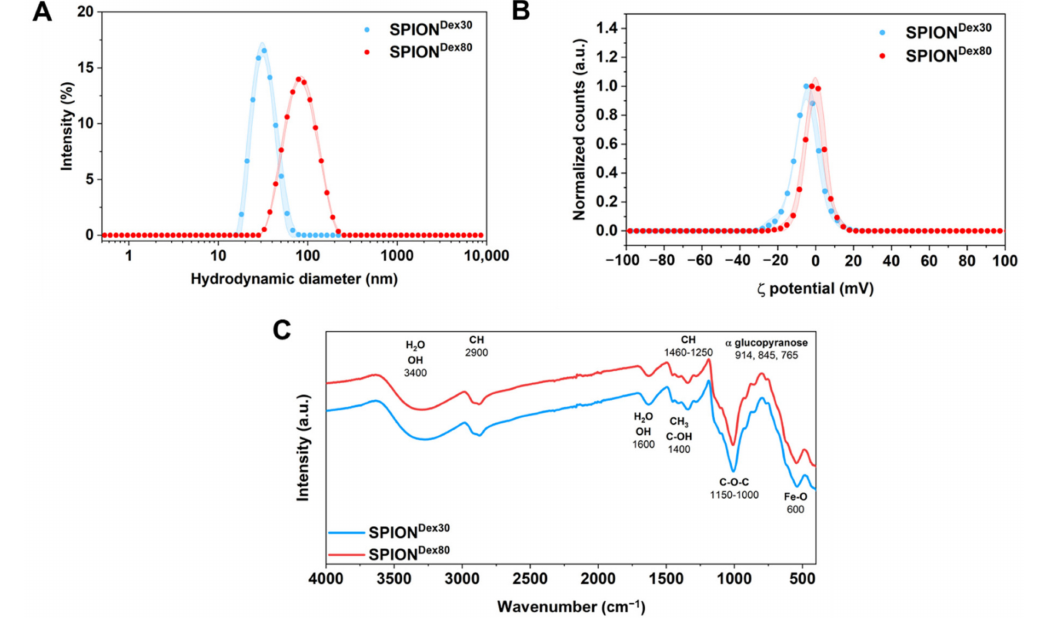
Figure 1. Physicochemical properties of differently sized SPION Dex . ( A ) Intensity-weighted hydro- dynamic size distribution of the particles with shadows showing the standard deviations of three independent experiments. ( B ) Normalized ζ potential distribution with shadows showing the stan- dard deviations of three independent experiments. ( C ) FTIR spectra of SPION Dex30 and SPION Dex80 with peak identification according to [30] reveal that there is no difference in surface